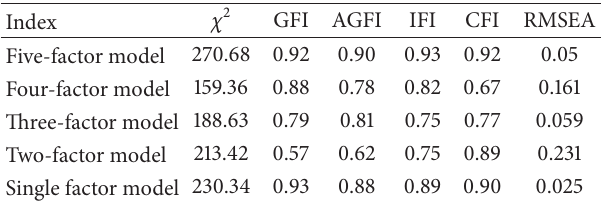
Table 1: Fit indexes of organizational resilience model. Table 2: Comparison of fit indexes of